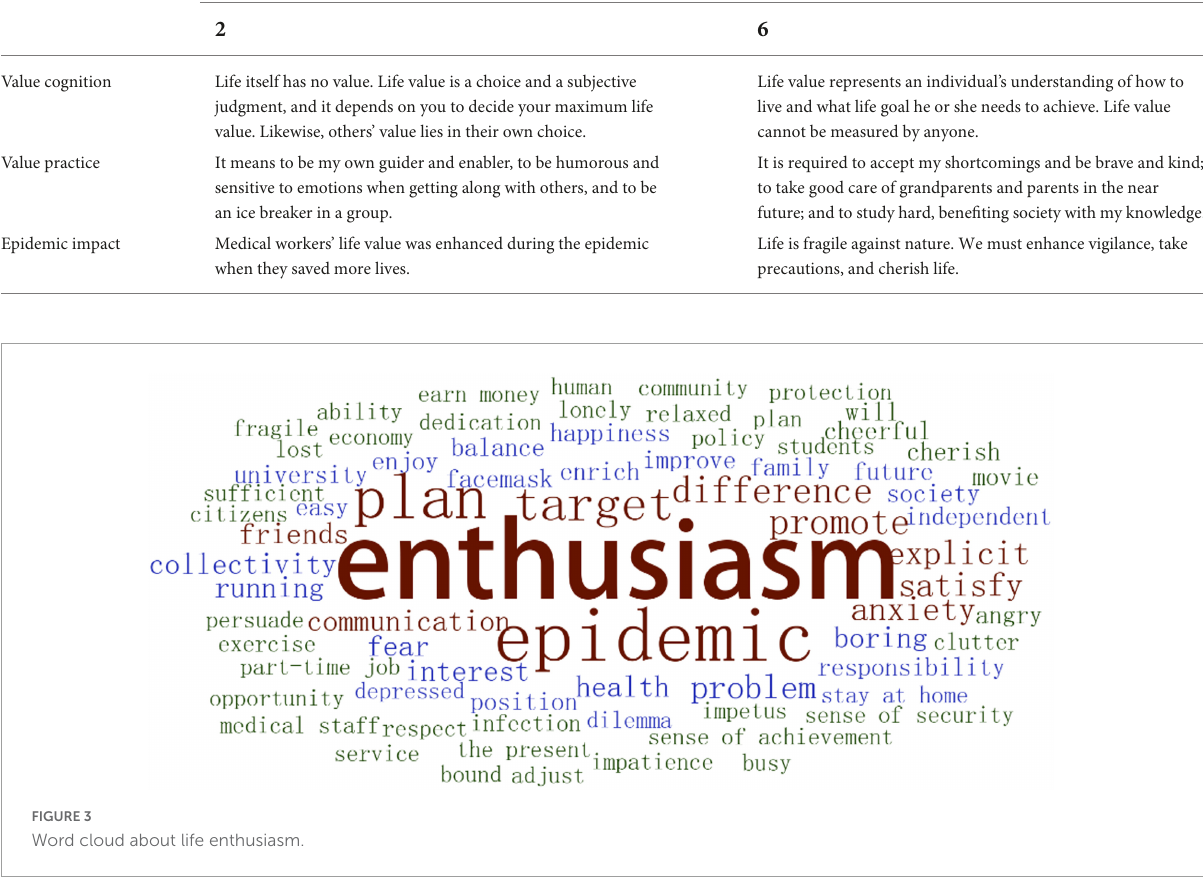
TABLE 5 Response examples about life value.